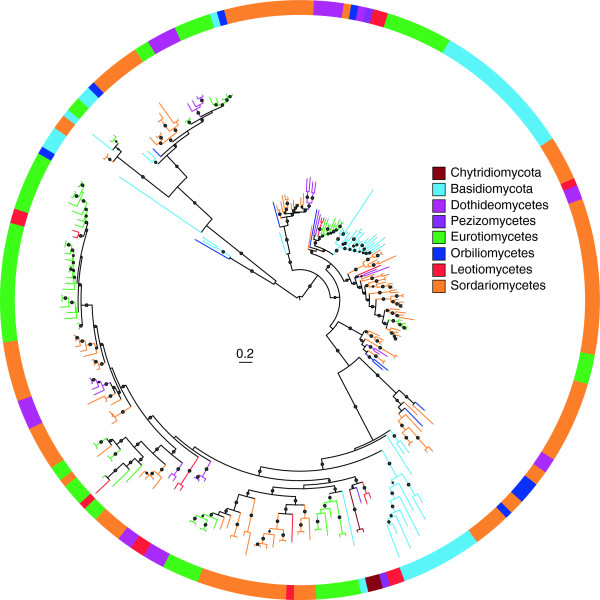
The maximum likelihood tree of family PL1. The phylogenetic tree was constructed with PhyML3.0 based on a multiple sequence alignment generated with PSI-Coffee [54]. The midpoint rooted base tree was drawn using Interactive Tree Of Life Version 2.1.1 (http://itol.embl.de/). The p-values of approximate likelihood ratios (SH-aLRT) plotted as circle marks on the branches (only p-values >0.5 are indicated) and circle size is proportional to the p-values. Scale bars correspond to 0.2 amino acid substitutions per site. A detailed version of this tree is found in Additional file 8.